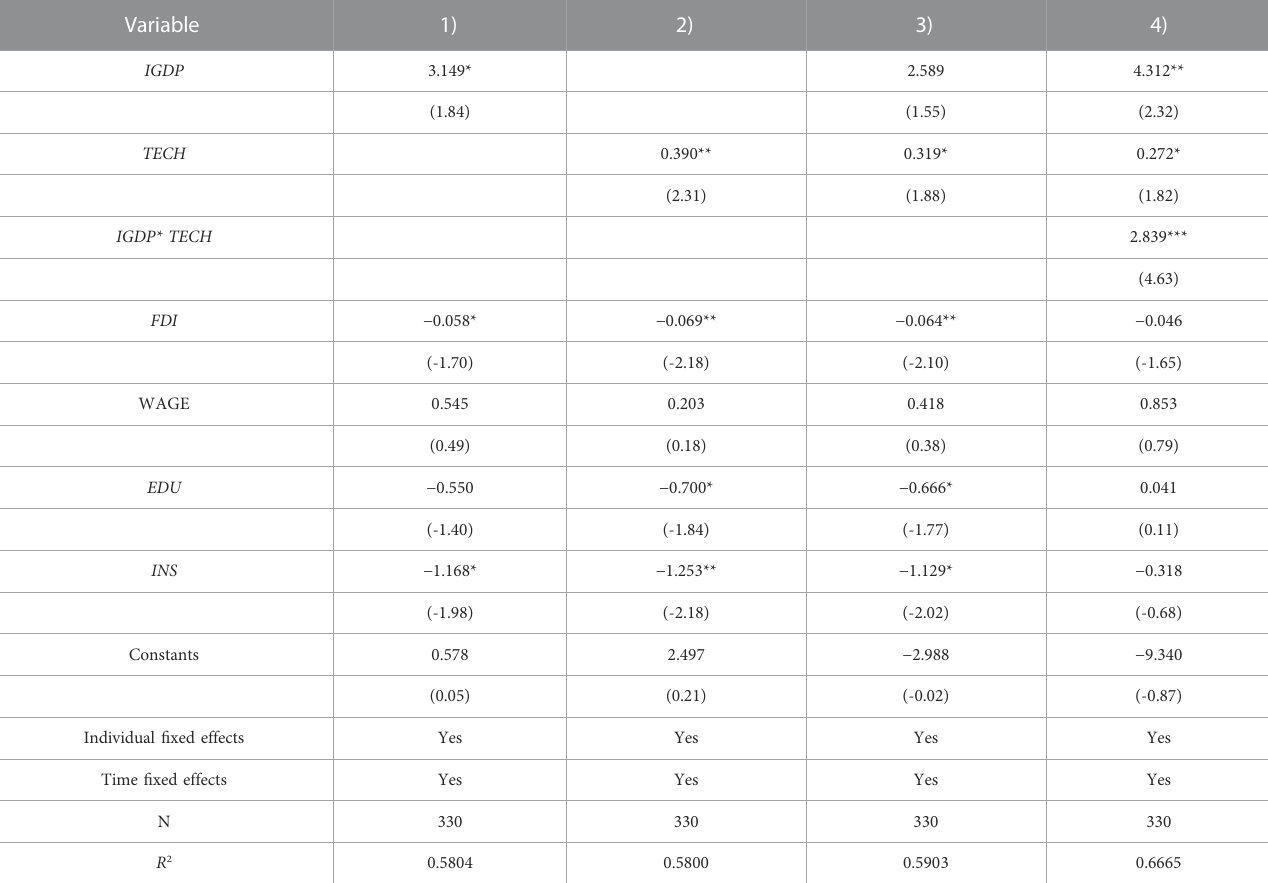
TABLE 6 Industrial green development, technological innovation, and employment structure.